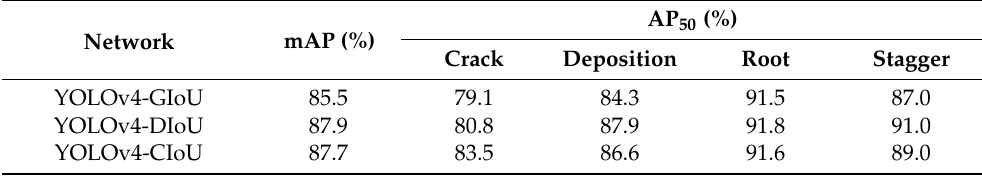
Table 4. The mAP and AP of each model for each defect